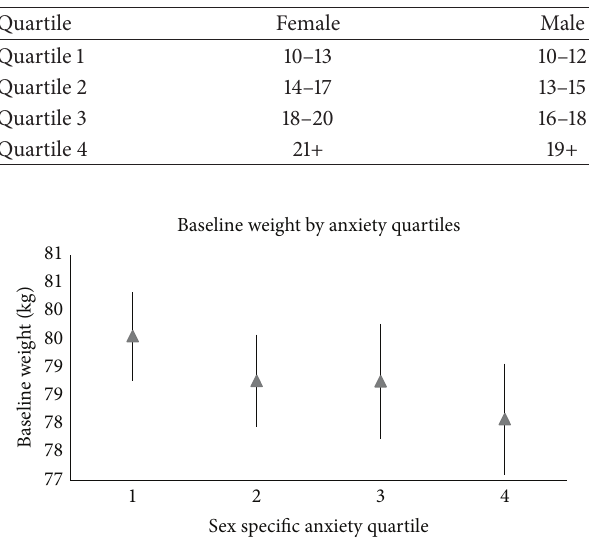
Table 1: Gender-specific anxiety score ranges by Spielberger State- Trait Personality Inventory quartile.